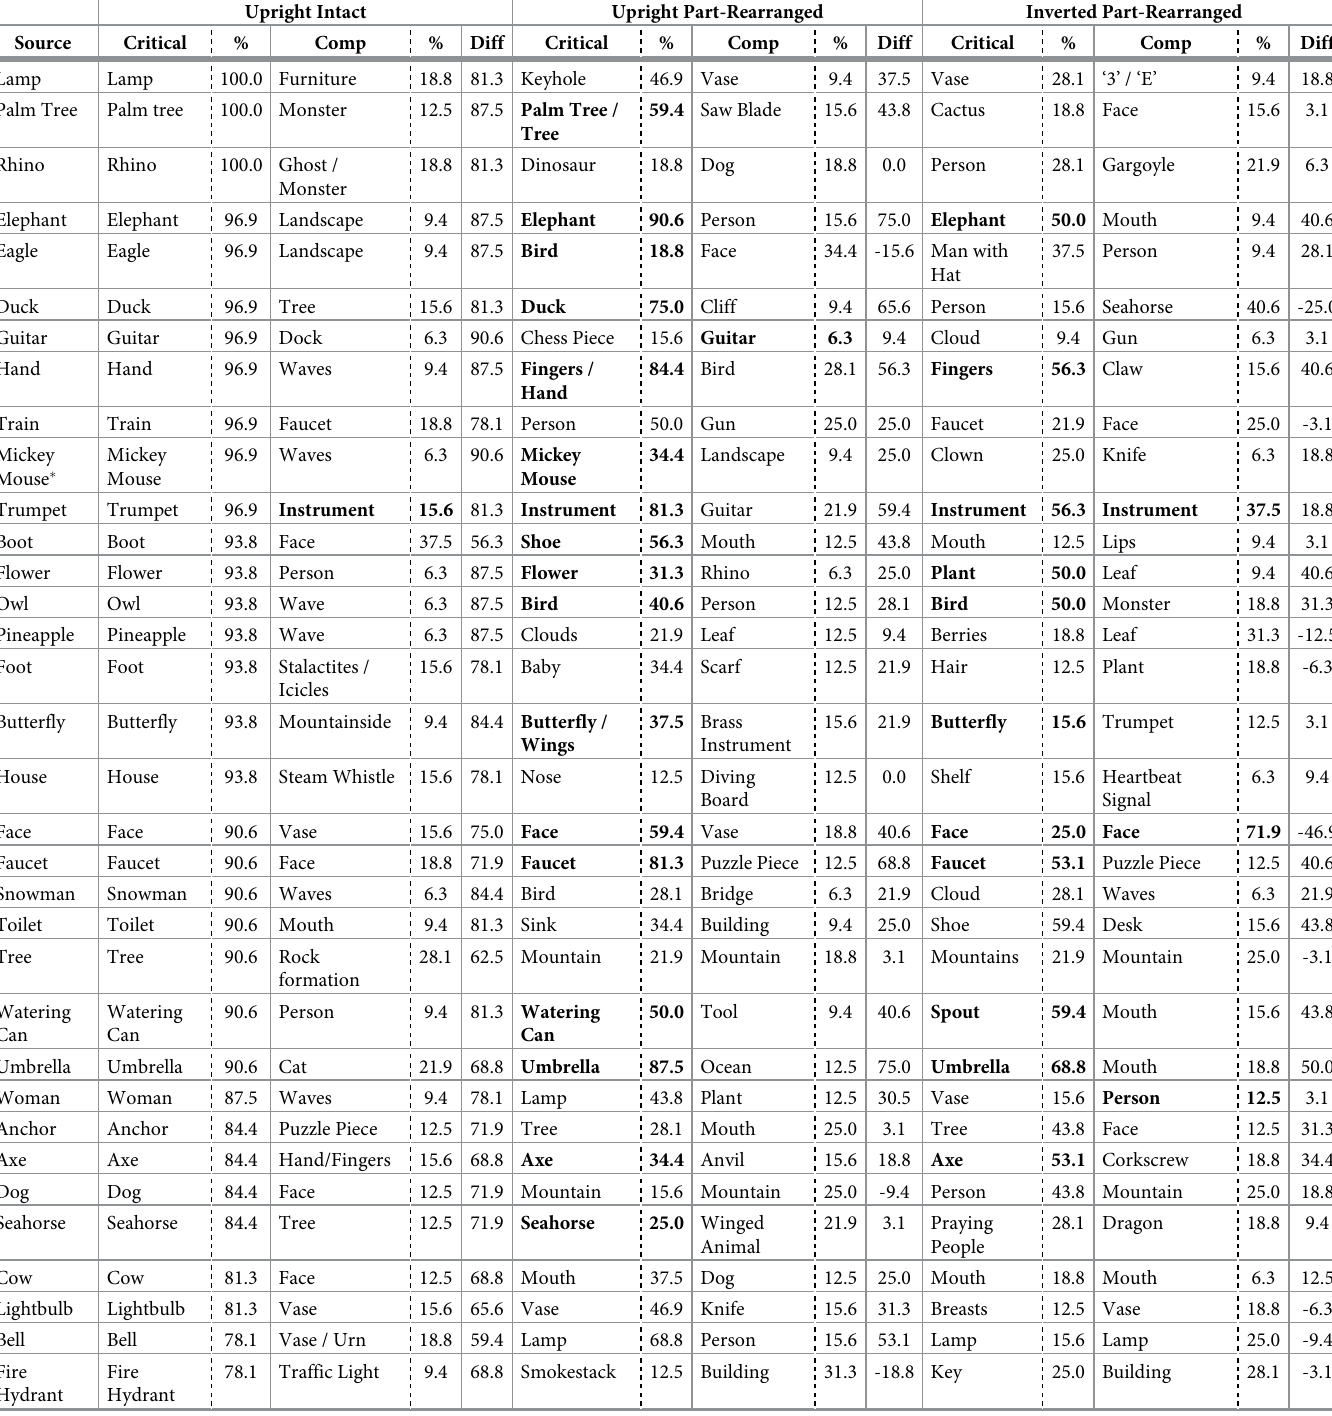
Table 1. Percent inter-subject agreement for each side (critical and complementary) and critical–complementary difference scores for three types of OMEFA-II bipartite stimuli: Upright Intact , Upright Part-Rearranged , and Inverted Part-Rearranged . Upright Intact Upright Part-Rearranged Inverted